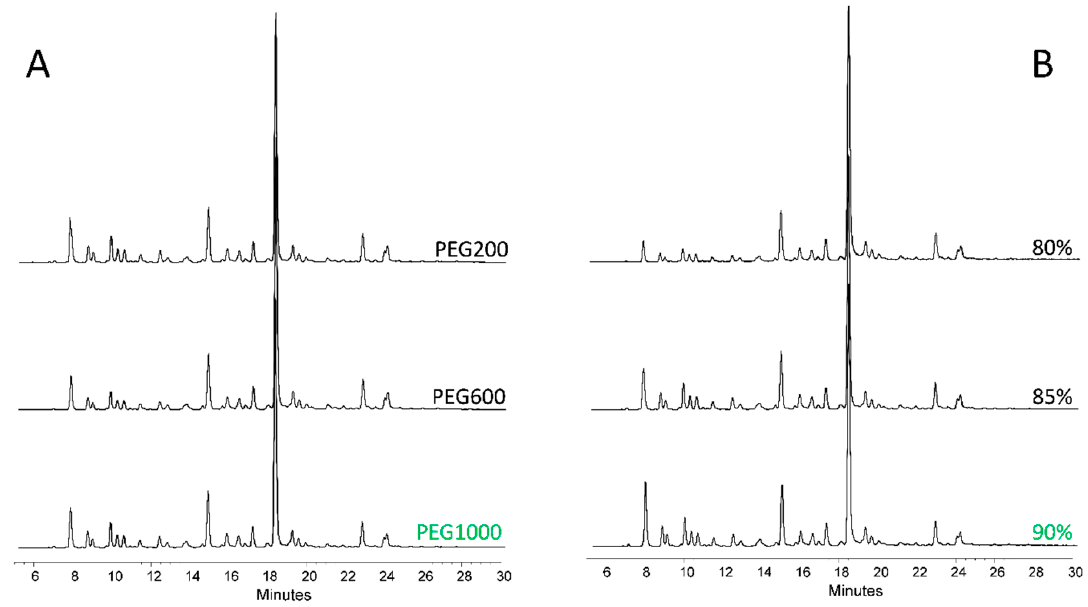
Figure 1. 2-AA labelled serum glycan profiles purified by iron-nanoparticles ( A ) and different acetonitrile concentrations ( B ).